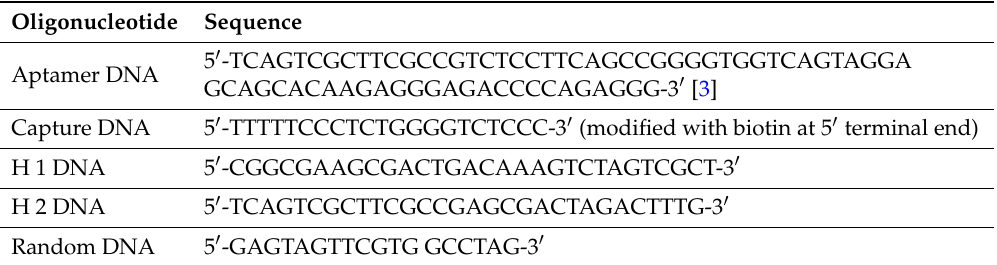
Table 1. Sequences of the oligonucleotides used in this